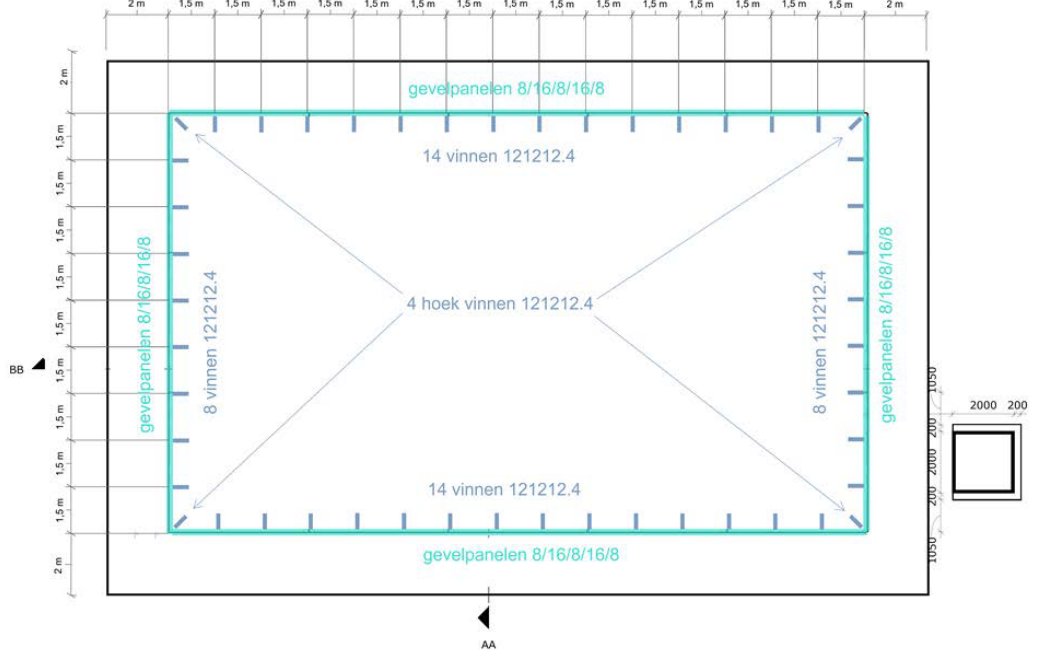
Fig. 3 stabilizing and bearing glass structure in plan.